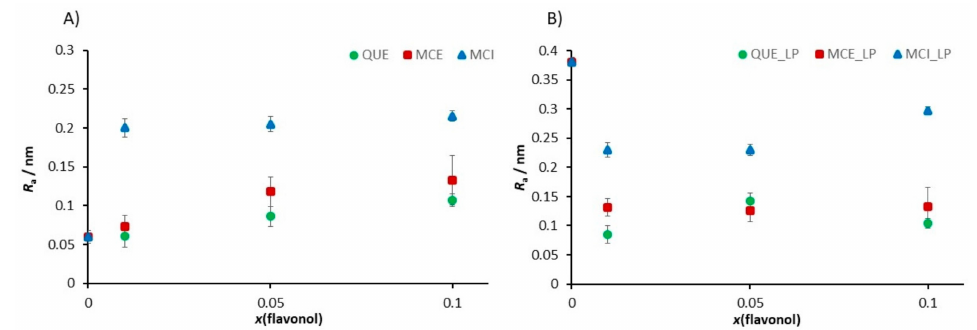
Figure 12. The change in the roughness value induced ( A ) by the insertion of flavonols in dependence of the molar fraction of inserted flavonols and ( B ) by the induced lipid peroxidation process in the SLB as a function of the molar fraction of inserted flavonols.